Question: Sum up the contents of this chart in one sentence.
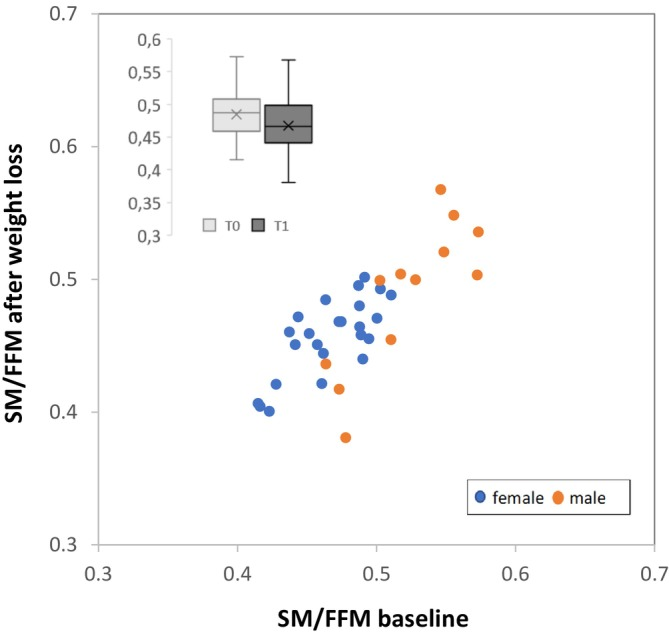
Answer: Ratio of skeletal muscle mass (SM, measured by whole body MRI) to fat‐free mass (FFM, measured by air displacement plethysmography) at baseline (T0) and after diet‐induced weight loss (T1; the ratio of SM to FFM decreased from 0.485 to 0.467; p < 0.001) in 36 men and women who lost ≥ 0.5 kg of FFM and SM. Data are taken from Pourhassan et al. (2013) [ 101 ].